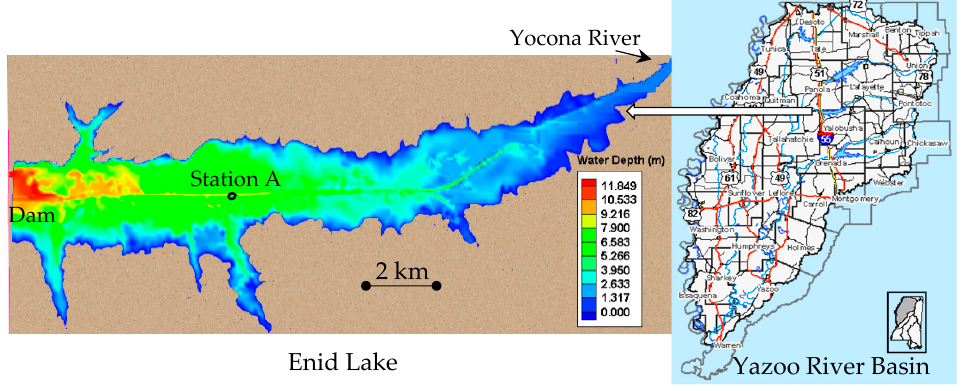
Figure 1. Study Area.